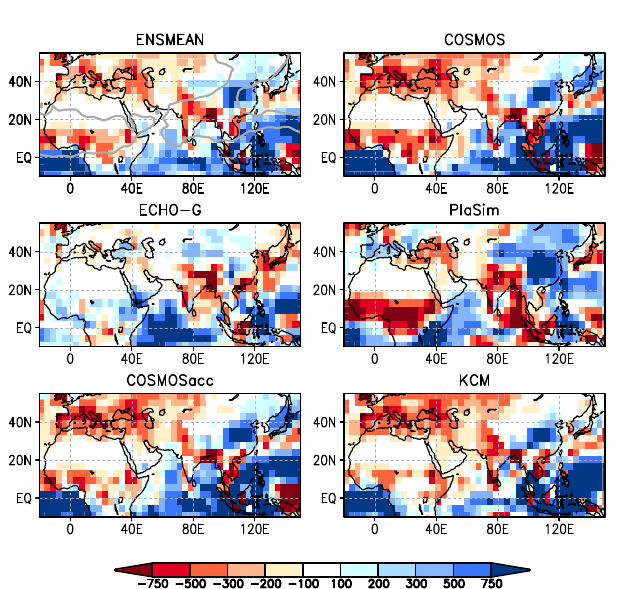
Figure 2. Biases in annual mean precipitation (mmyear − 1 ) be- tween the different transient simulations (last 100 years, i.e. 0k) and the modern observed climate, represented by the precipitation data of the Global Precipitation Climatology Project (GPCP, 1979–2008, Adler et al., 2003). The grey line in the plot of the ensemble mean marks the simulated pre-industrial Afro-Asian monsoon region, i.e the 55% isoline of the summer to annual precipitation.